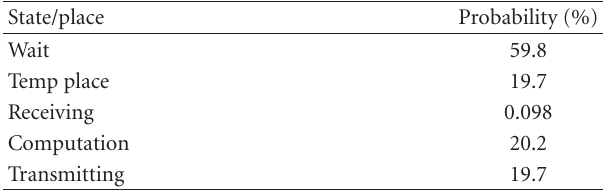
Table 9: Steady-state probabilities for a simple system.